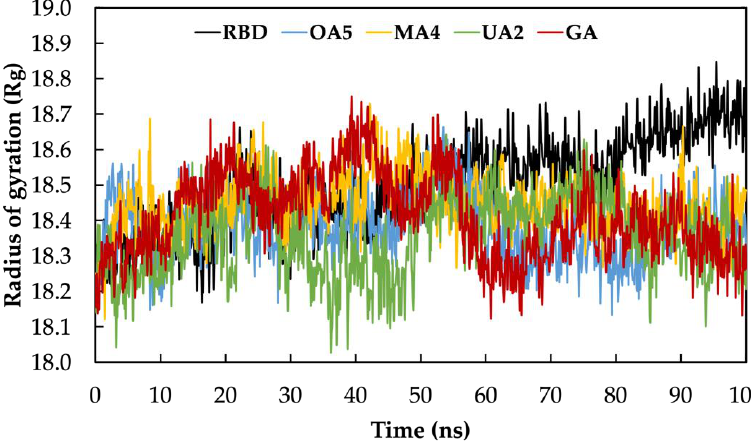
Figure 4. Radius of gyration computed along the MD simulation time.